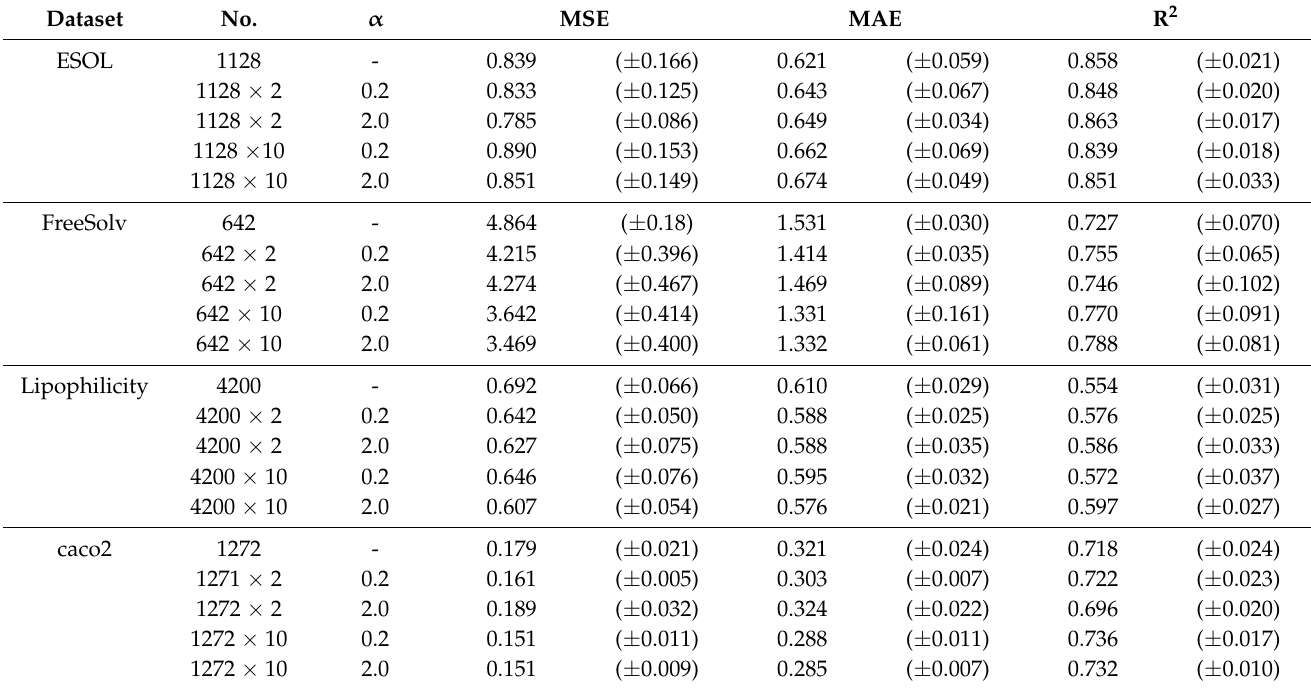
Table 3 Effect of mixup on performance of the four datasets using CNN model using MTM.